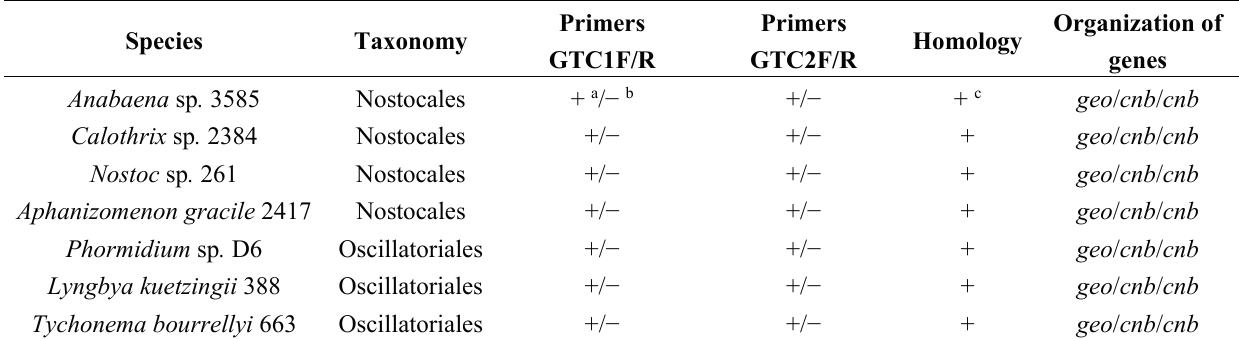
Table 1. Organization of the operon in other geosmin-producing cyanobacteria.